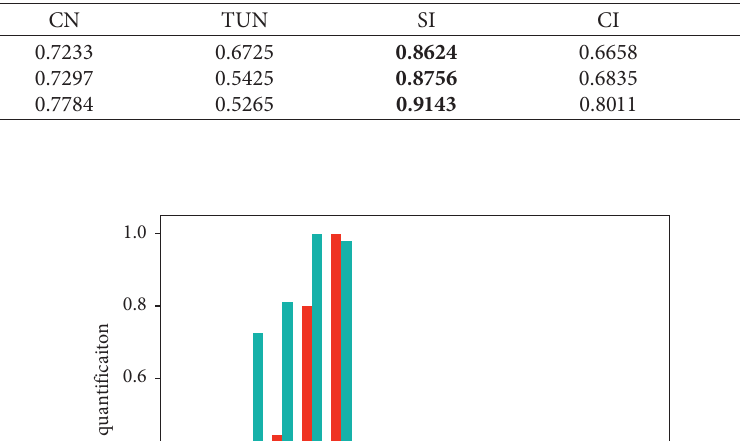
Table 2: Correlation analysis results of explanatory variables.